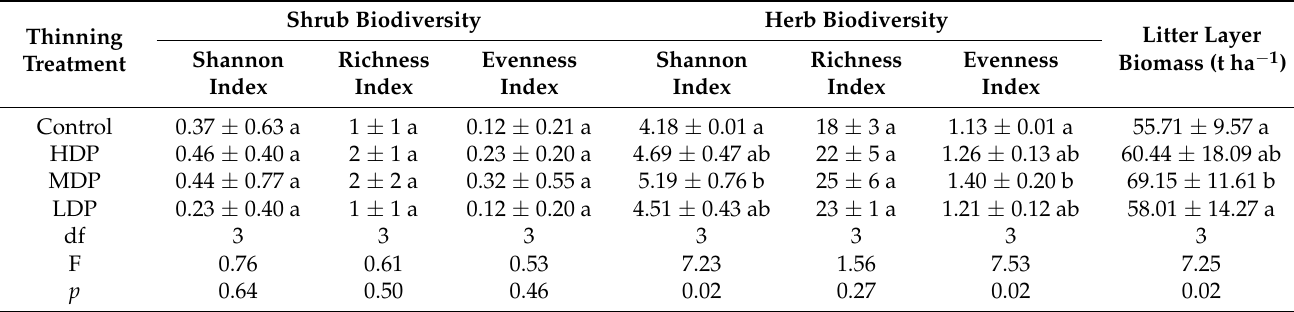
Table 2. Characteristics of understory vegetation after thinning